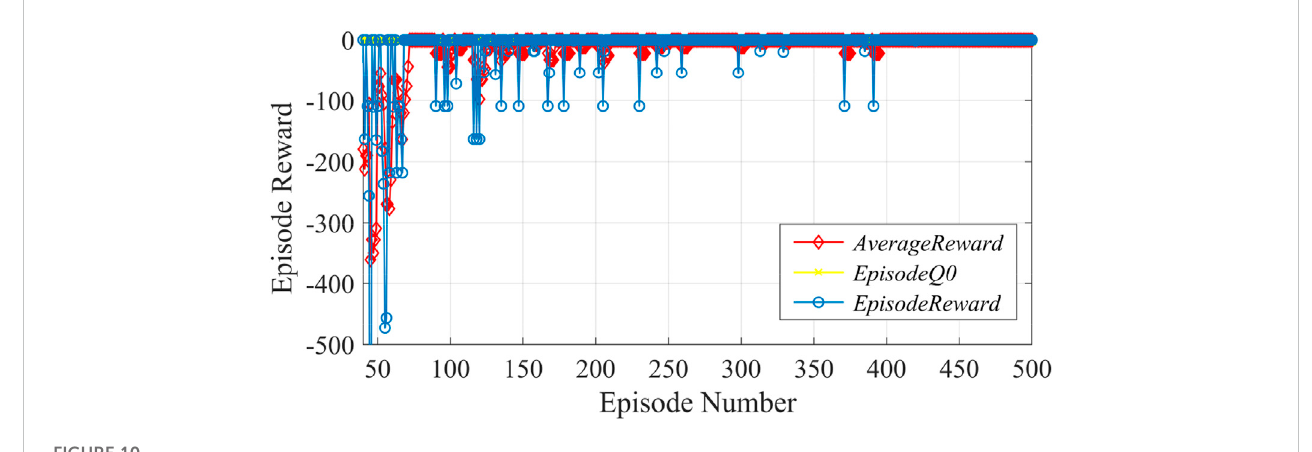
FIGURE 10 DQN agent training